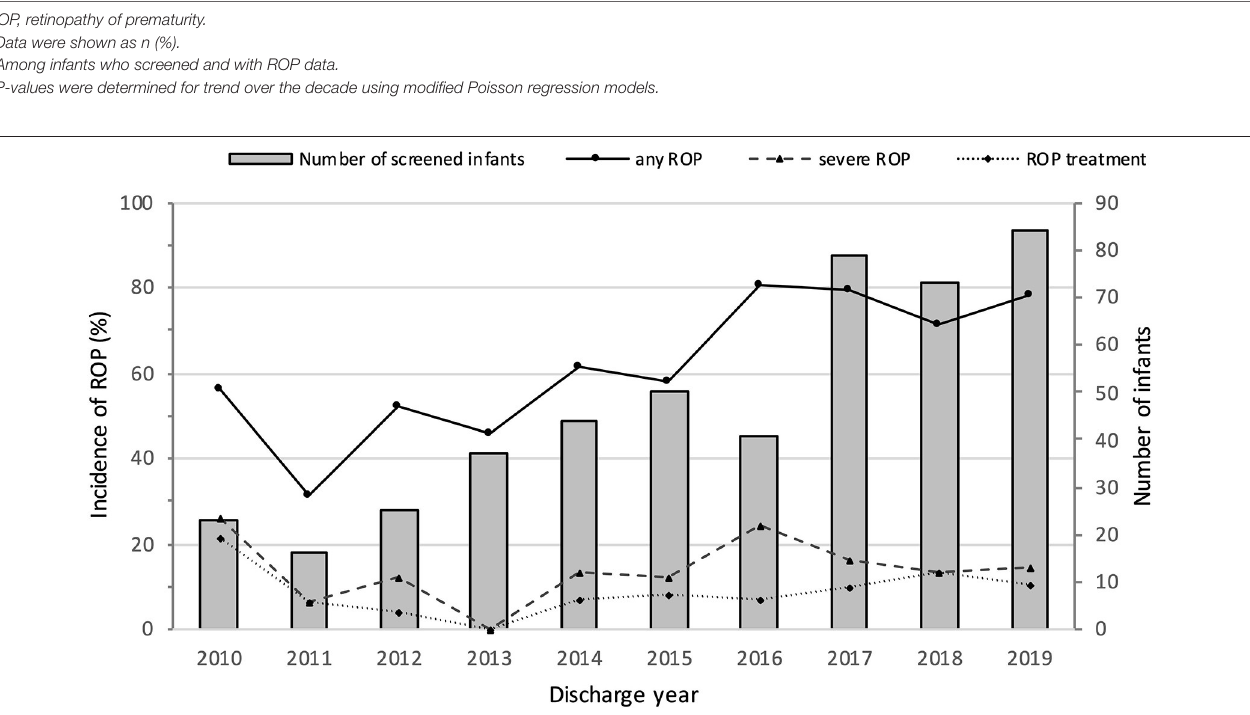
FIGURE 2 | Numbers of screened infants and incidence of ROP in extremely premature infants from 2010 to